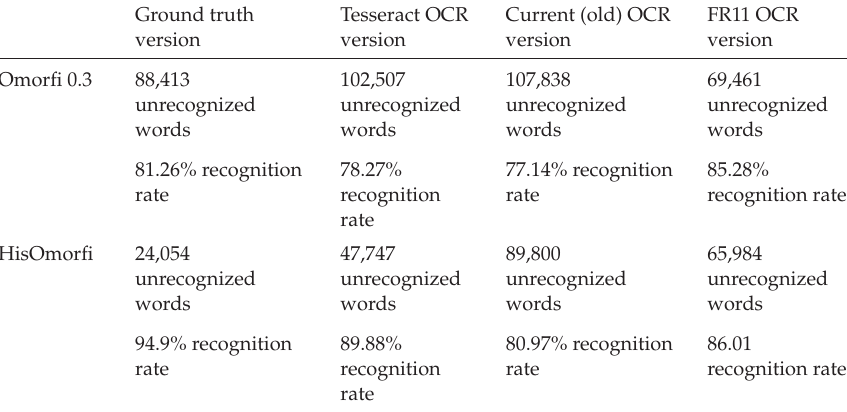
Table 1. Recognition rates for different comparable data: 471,903 words. Ground truth